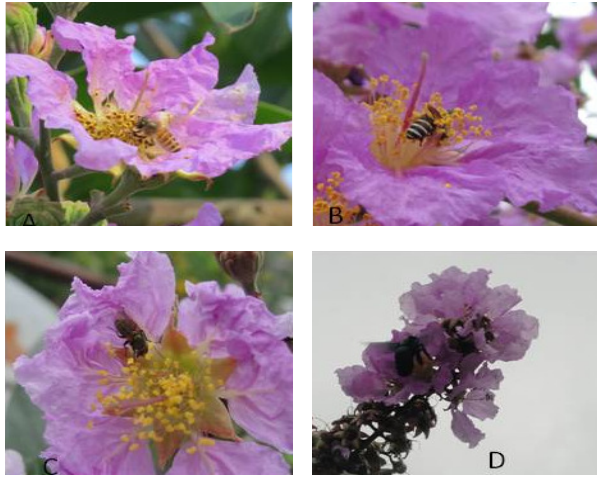
Fig. 6. Frequency of pollinator visits in respect to the time of day for L. speciosa in the year 2012 (values in parentheses indicate LSD values for 5%)